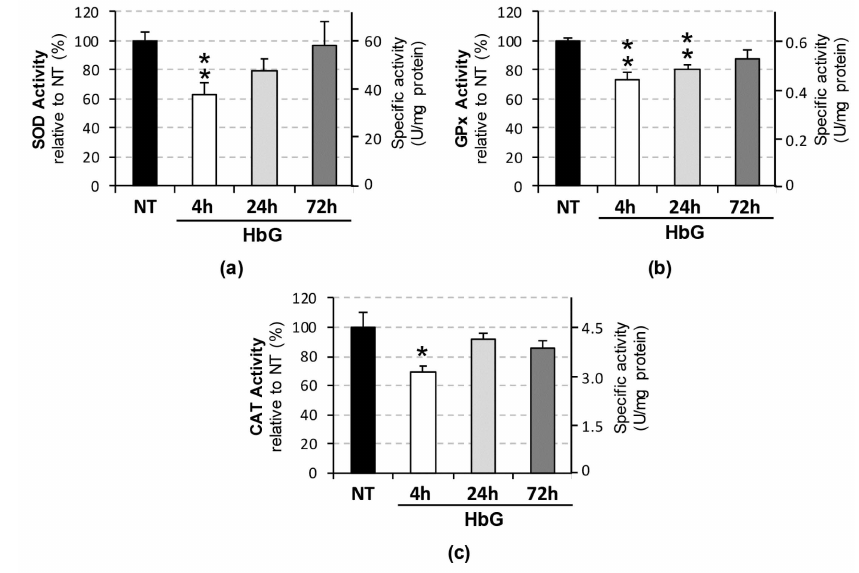
Figure 2. Renal antioxidant enzyme activities following infusion with HbG. Total SOD ( a ), GPx ( b ), and CAT ( c ) activities were measured at 4, 24, 72 h post-ET with HbG. Data are presented as percentage activities relative to NT (left axis) and estimated specific activities in U/mg protein (right axis). Values are calculated as the means ˘ SE for replicate experiments ( n = 3–5 animals per group). Asterisks indicate significant differences compared to NT (* p < 0.05, ** p <